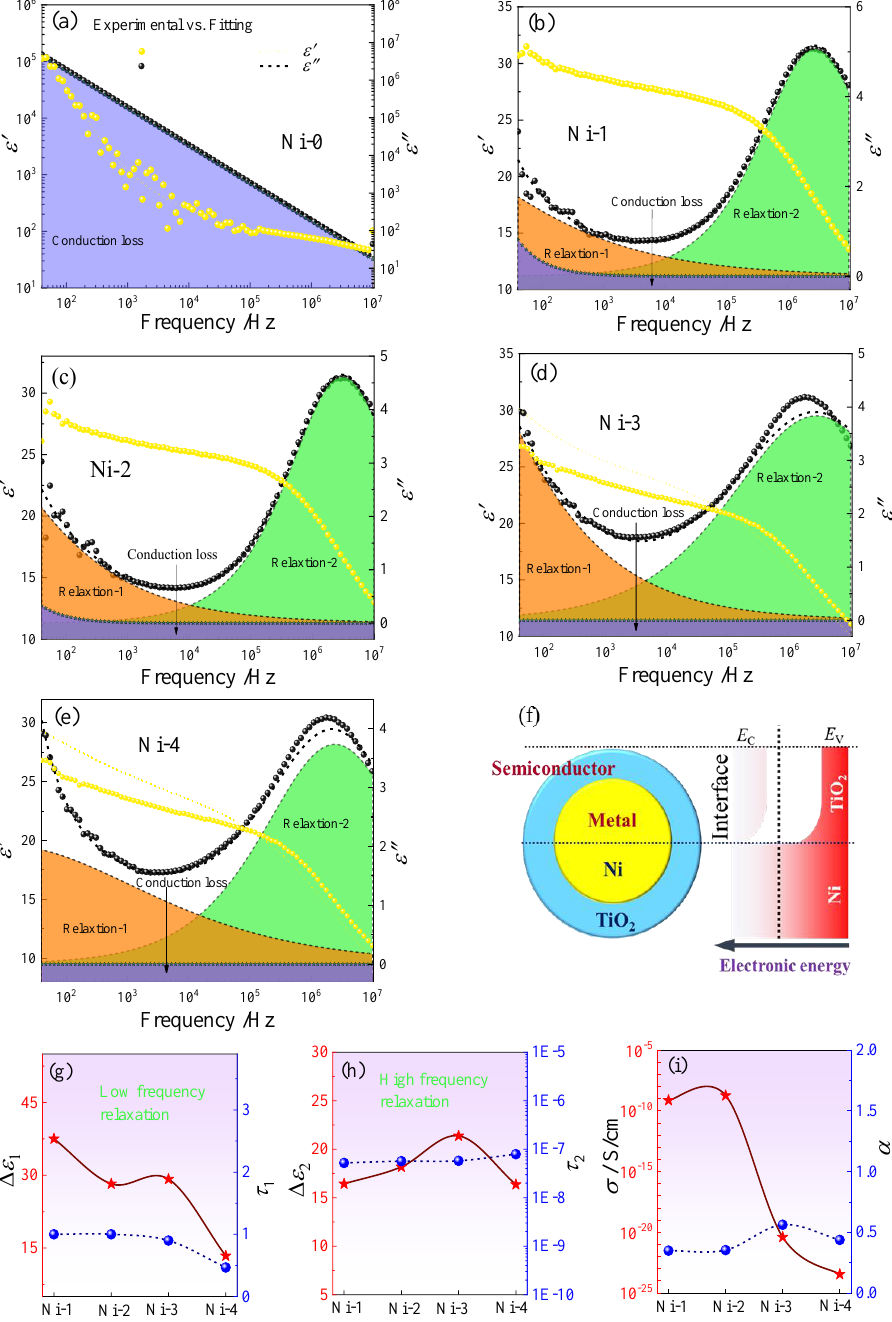
Figure 7. ( a – e ) Dielectric spectra of PVDF composites including various fillers (Ni–0~Ni–4) at 30 wt% deconvolutions into separate relaxations by H–N equation, ( f ) the schematic diagram of the influence of energy gap of core@shell structured Ni@TiO 2 , ( g – i ) summary and evolution of best–fitting parameters with different shell